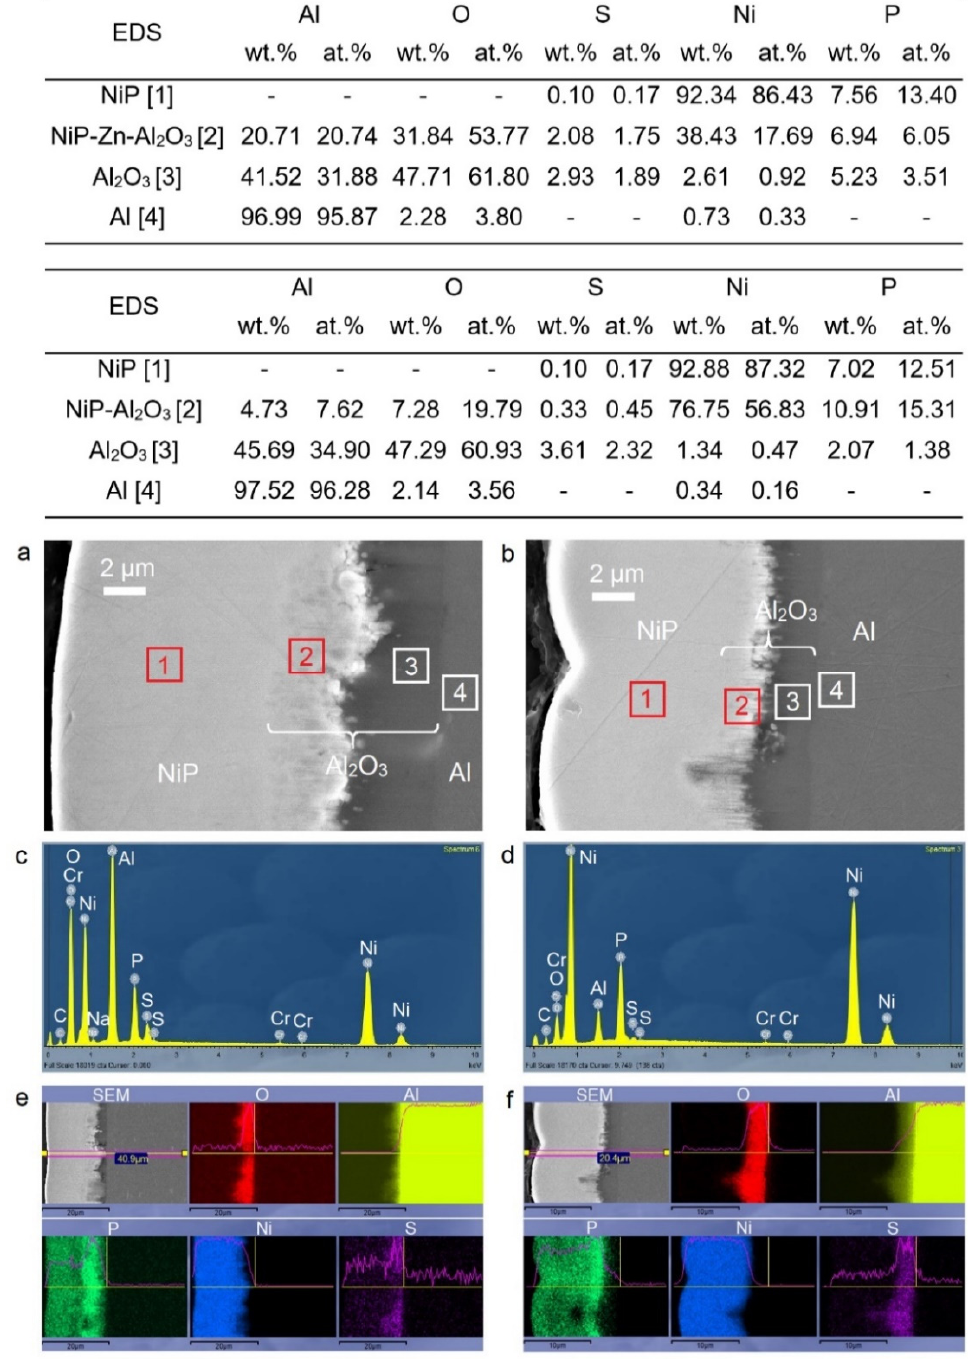
Figure 4. Cross-section, EDS and maps of Ni-P deposited on NAC: ( a , c , e ) with zincate treatment; ( b , d , f ) without zincate treatment.